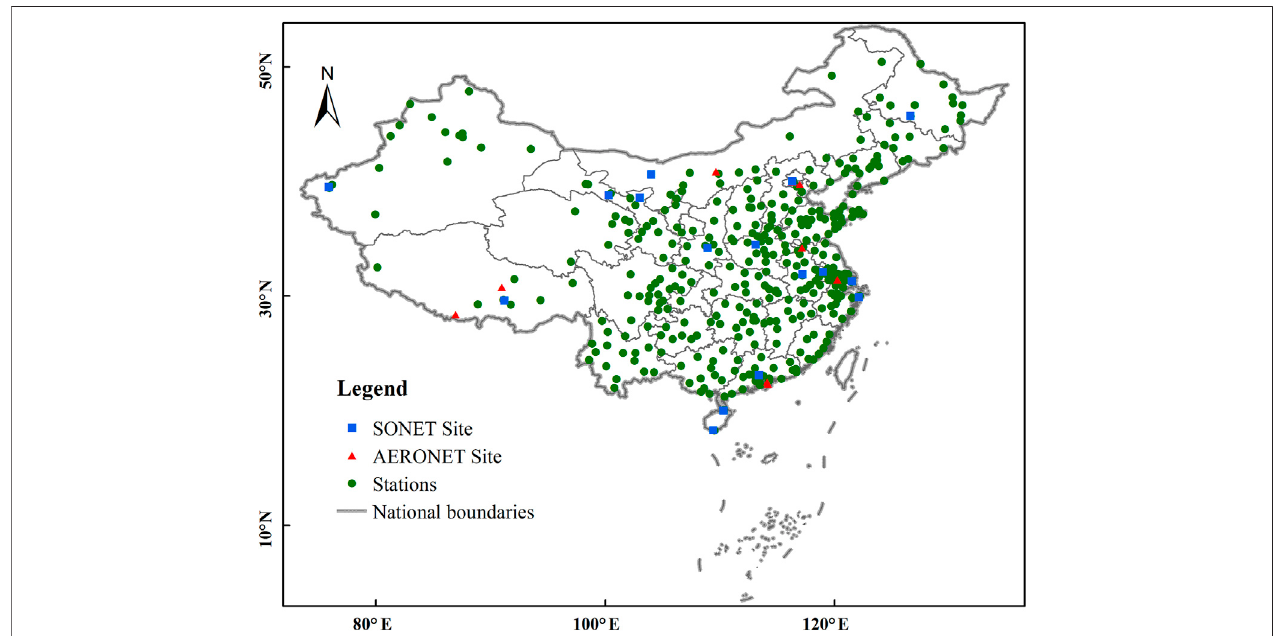
FIGURE1| Thespatialmapaboutthestudyareaandobservationstations,alongwiththesitesusedforevaluationofourstudyresults,whichareSONETsitesand AERONET sites.